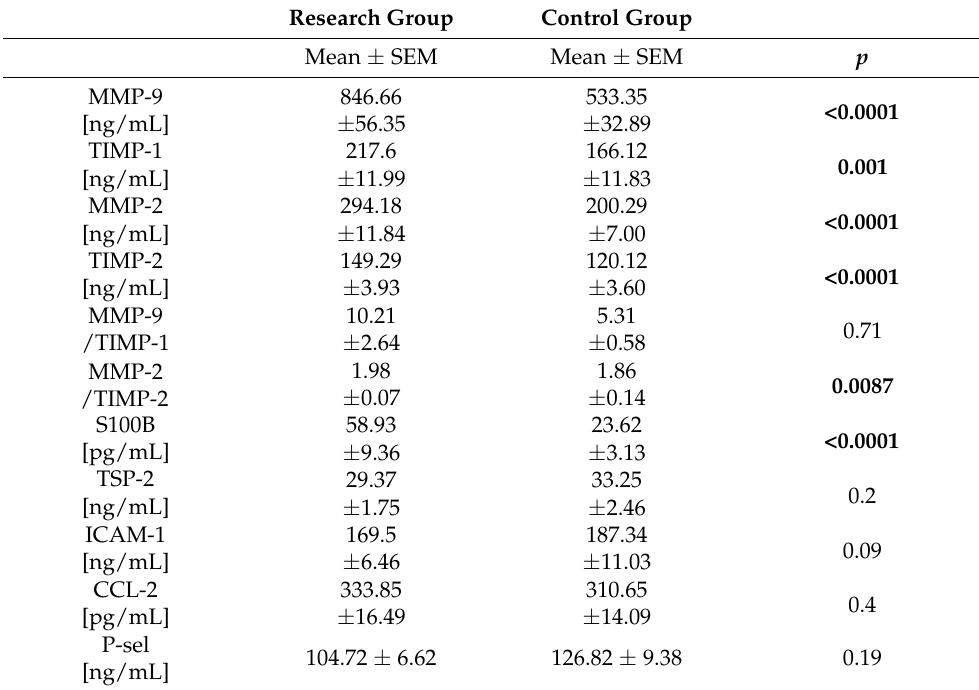
(Table 3). MMP-2/TIMP-2 ratio was also higher in the research group. Serum levels of the proteins associated with activation of endothelium (P-sel, ICAM-1), inflammation (CCL-2), and synaptogenesis (TSP-2) did not differ between the two groups. Table 3. Means and SEM values of examined proteins. Wilcoxon’s test.